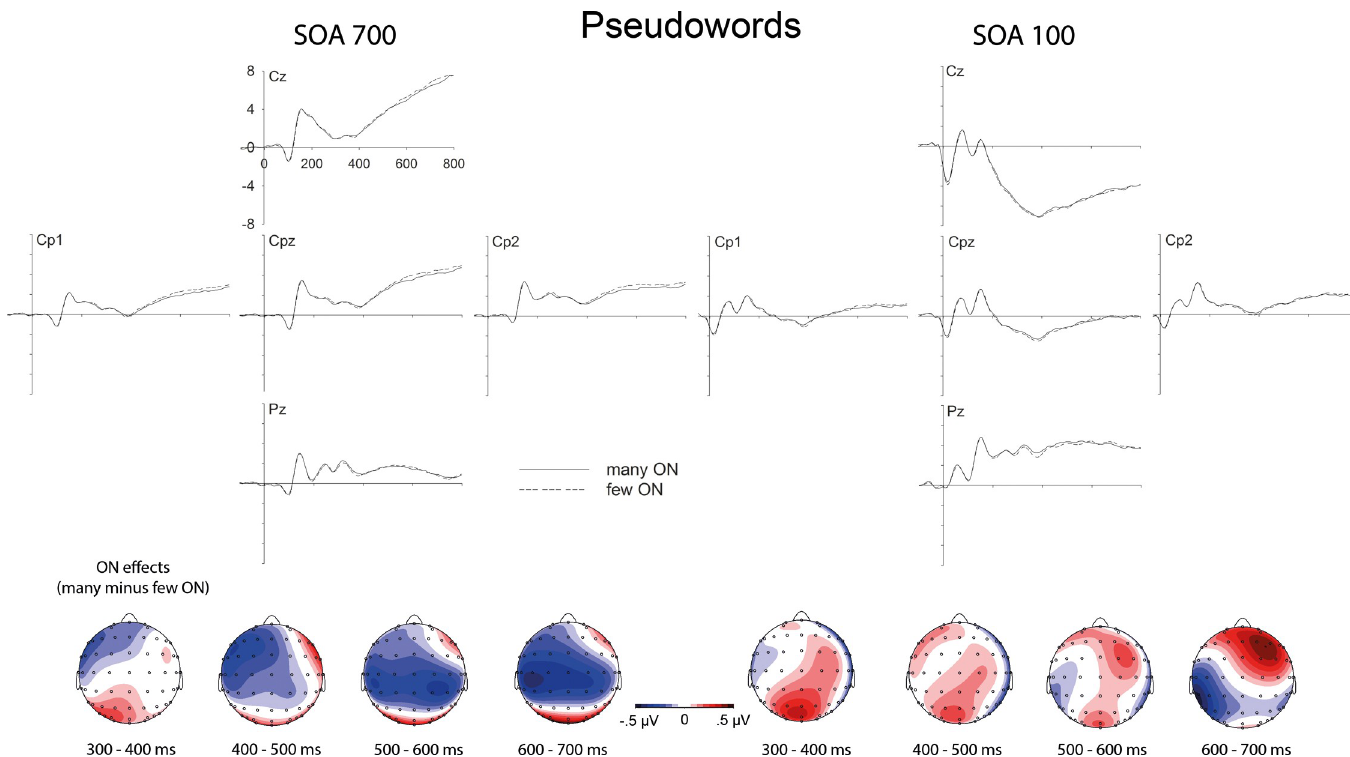
Fig 4. Orthographic neighborhood effects on event-related brain potentials to pseudowords. Top. Influences of orthographic neighborhood (ON) size on event-related brain potentials at centro-parietal electrode sites, to the left in conditions of low task overlap (SOA 700) and to the right in conditions of high task overlap (SOA 100). Bottom. Topographical distributions of the above depicted ON effects (many minus few ON).